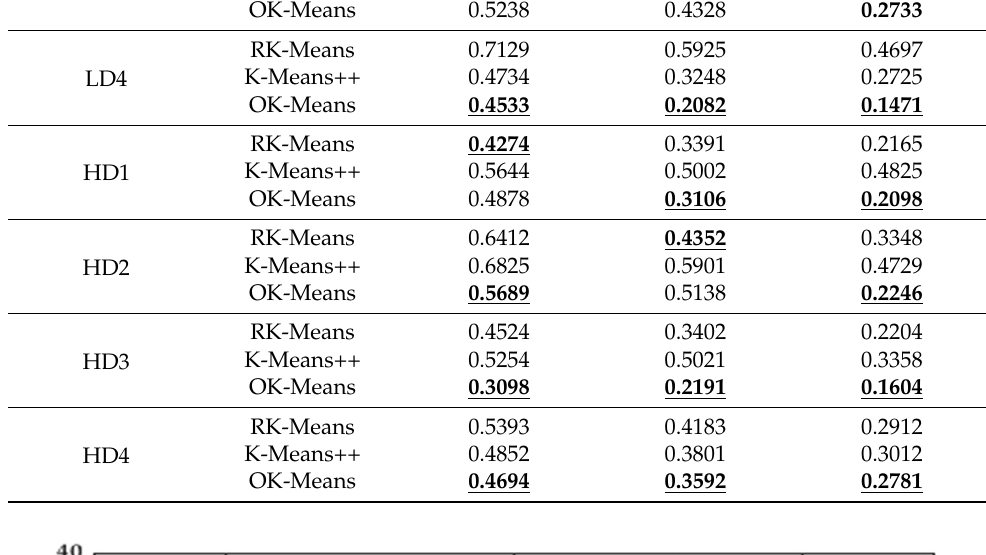
bold underlined RMSE values in Table 7 represent good results and indicate that the proposed algorithm had high similarity compared with the others. The RMSE value of the proposed model in the LD scenario was better than that of the K-Means++ and OK-Means models, though it demonstrated only small improvements compared with OK-Means. In the HD scenario, the proposed model demonstrated improvements compared with the others, indicating that it performed most effectively in the high-density scenario when the evaluation was based on the minimum average value. The effectiveness in high-density scenarios was the primary